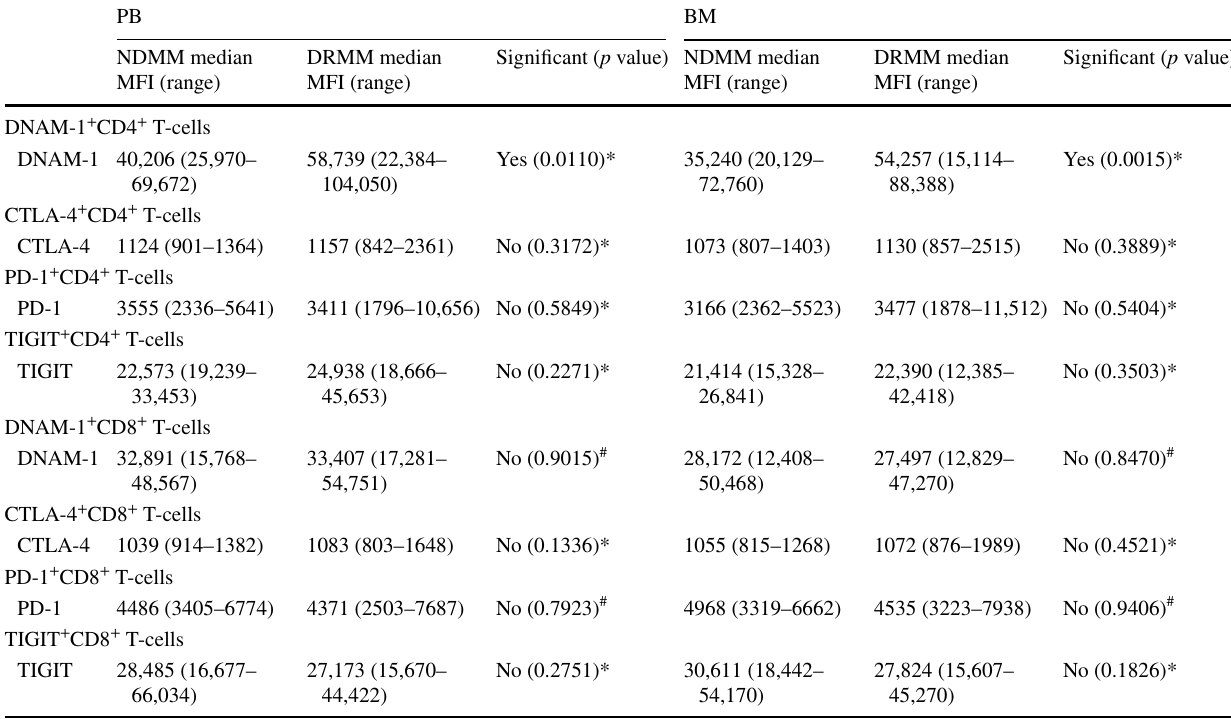
Table 3 MFI of immune checkpoint receptors on receptor positive subset of CD4 + and CD8 + T cells in myeloma